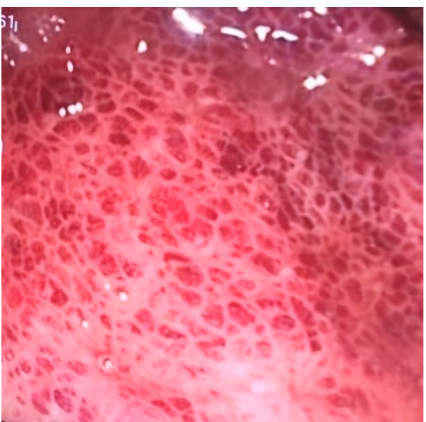
Figure 1. Sigmoidoscopy image of COVID-19 colitis showing submucosal bleeding.